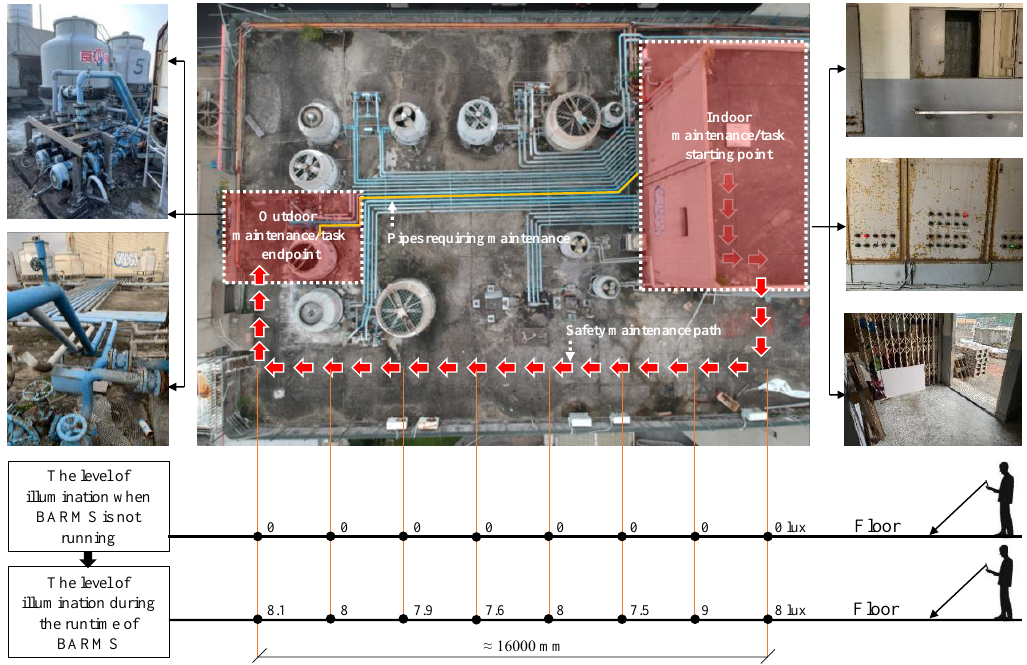
Figure 5. Sequence of operational procedures.